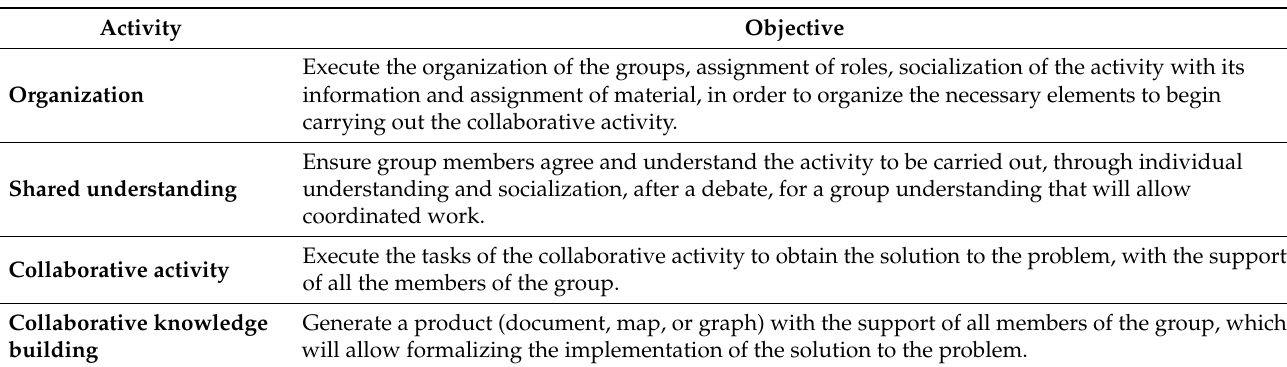
Table 2. The objective of each of the process